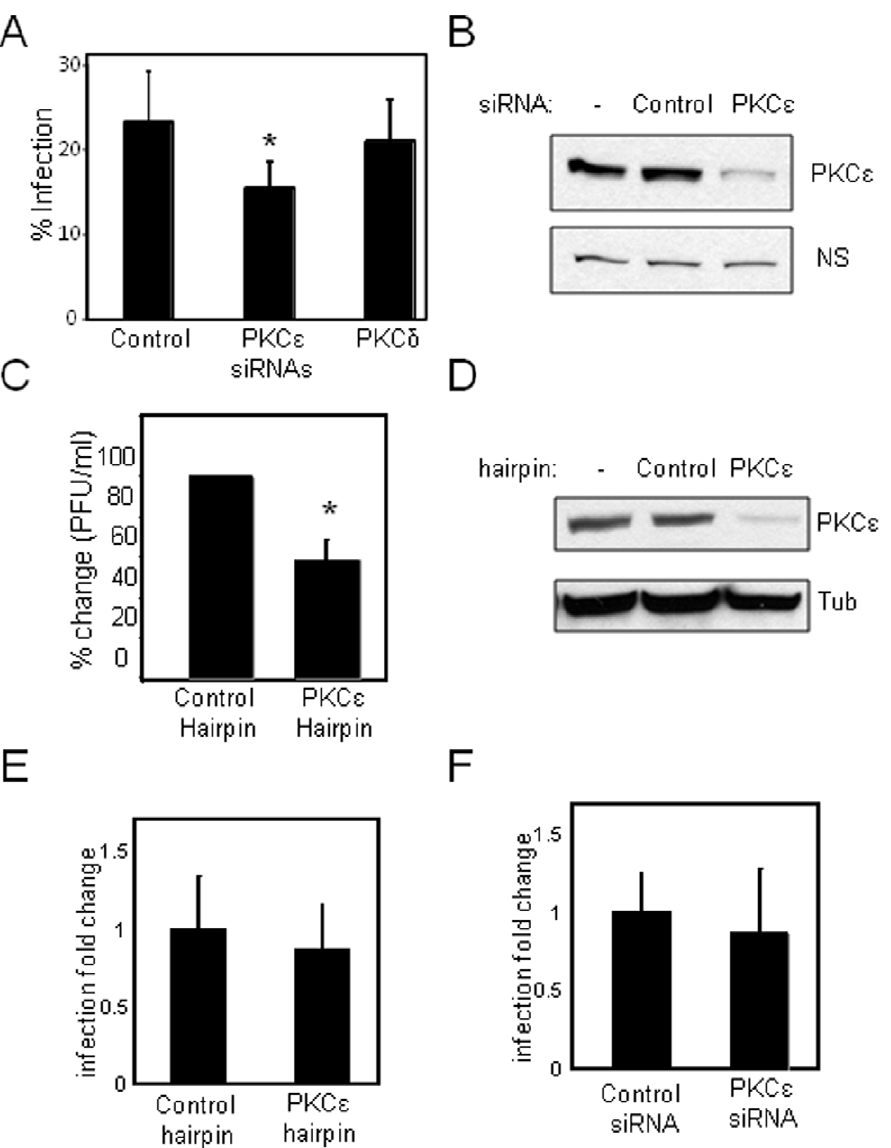
Figure 5. PKCepsilon is required for RVFV infection of human cells. A . Human 293T cells were transfected with siRNAs against a control, or the novel PKC isozymes PKC d or PKC e . The depleted cells were challenged with RVFV MP12 (MOI=1) for 12 hours were processed for immunofluoresecnce and quantified. Mean 6 sd for three experiments; * p , 0.02. B . PKC e is depleted by siRNA treatment as measured by immunoblot compared to a non-specific control (NS). C . Human H358 cells stably expressing either a control hairpin or a PKC e specific hairpin were challenged with RVFV MP12 for plaque assays in duplicate for each experiment, averaged, and the fold-change compared to control of the pfu/mL was averaged across three independent experiments; * p , 0.02. D . PKC e was depleted by RNAi as measured by immunoblot compared to a tubulin control. E . Human 293T cells were transfected with siRNAs against a control, or the PKC e and the depleted cells were challenged with poliovirus for 8 hours, processed for immunofluorescence and quantified. Mean 6 sd for three experiments. F . Human H358 cells stably expressing either a control hairpin or a PKC e specific hairpin were challenged with poliovirus for 8 hours, processed for immunofluorescence and quantified. Mean 6 sd for three